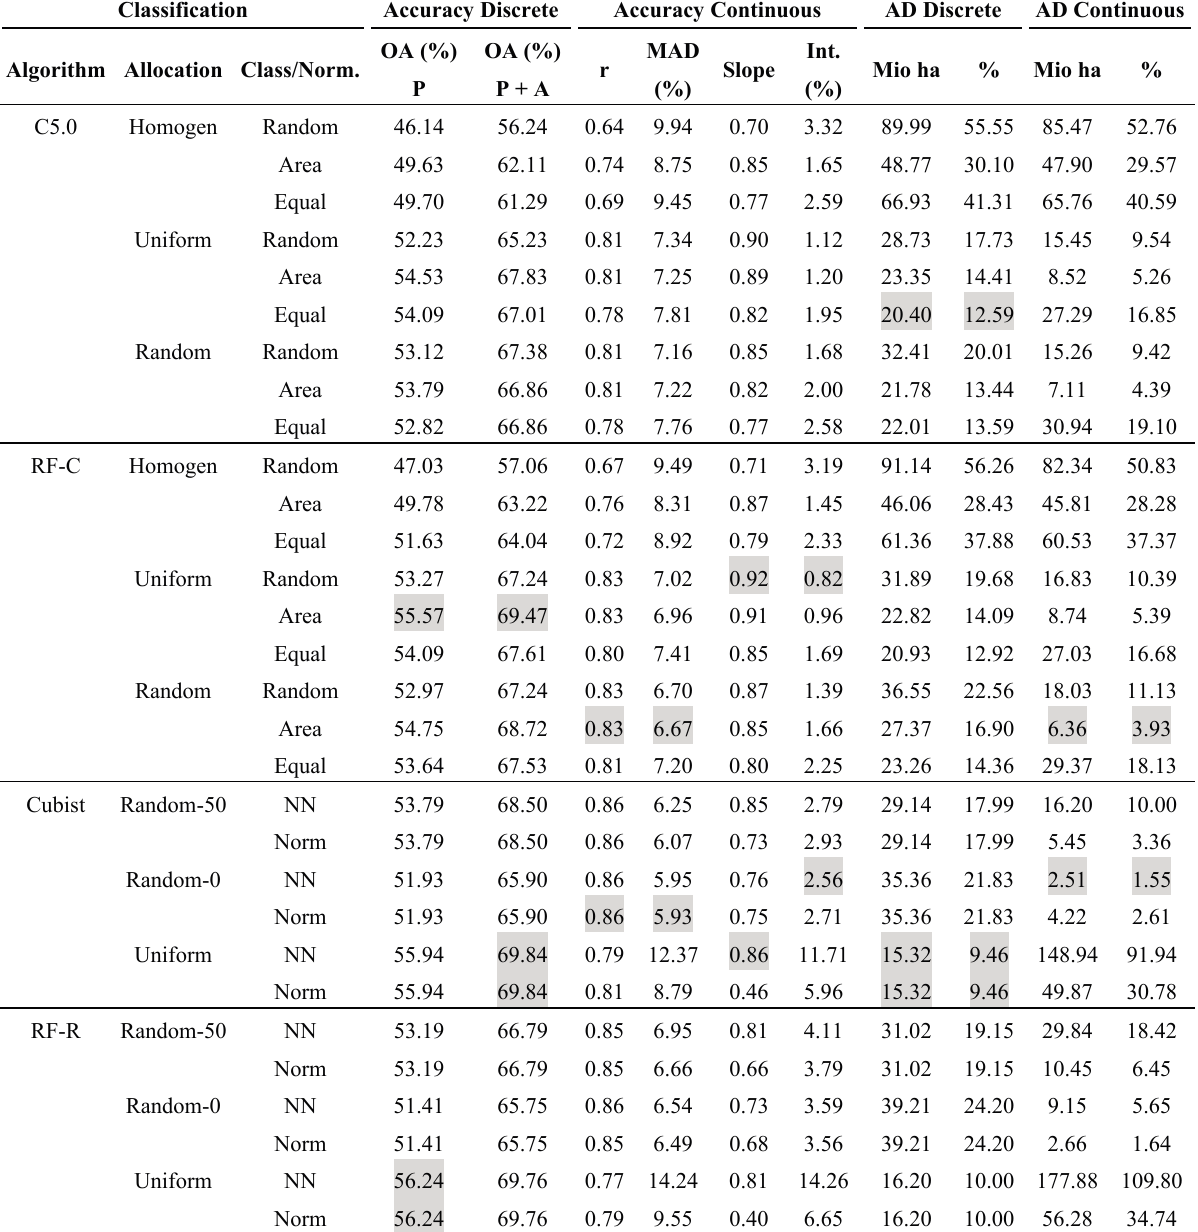
Table 9. Accuracy measures and absolute difference in area for discrete and continuous (class memberships) classifications. OA: overall accuracy using primary (P) or primary and alternative (P + A) label of reference data as correctly classified. r: correlation coefficient. MAD: mean absolute difference. Int: Intercept. AD: absolute difference in million hectares and percent. Classification trees C5.0 and Random forest classification (RF-C) with homogeneous samples (H = 100) or heterogeneous samples allocated uniformly for H ≥ 50% or randomly ( argmax(H) ). Sample allocation between classes with random, area-proportional, equal allocation. Regression trees Cubist and Random Forest Regression (RF-R) with uniform and random allocation with no minimum or at least 50 samples per bin. NN: no normalization. Norm: normalization. Highlighted cells indicate best results for classification and regression trees. Classification Accuracy Discrete Accuracy Continuous AD Discrete AD Continuous OA (%) Algorithm Allocation Class/Norm. P